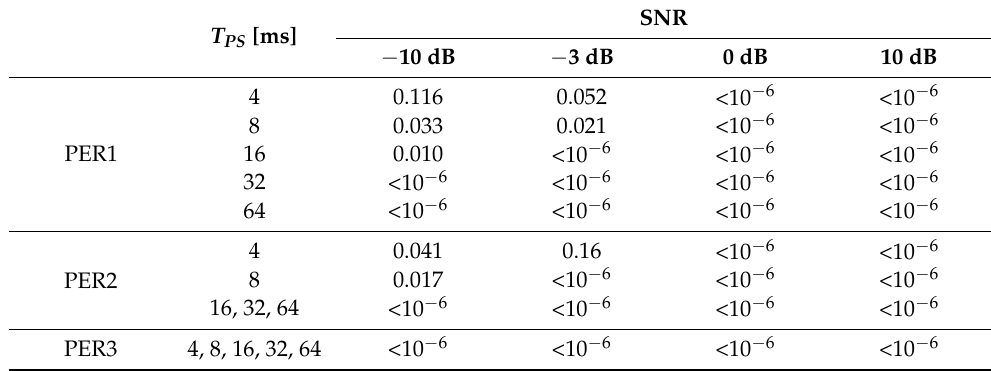
Table 3. Preamble Error Rate (PER) values for different values of T PS and SNR—channel NOF1.